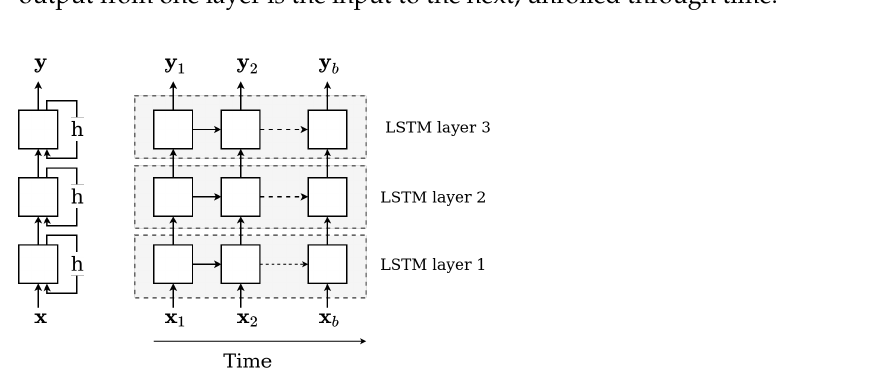
Figure A4. A recurrent neuron ( left ) that is unrolled through time ( right ). A deep, stacked RNN with 3 layers is illustrated in Figure A5. Here we see how the output from one layer is the input to the next, unrolled through time.